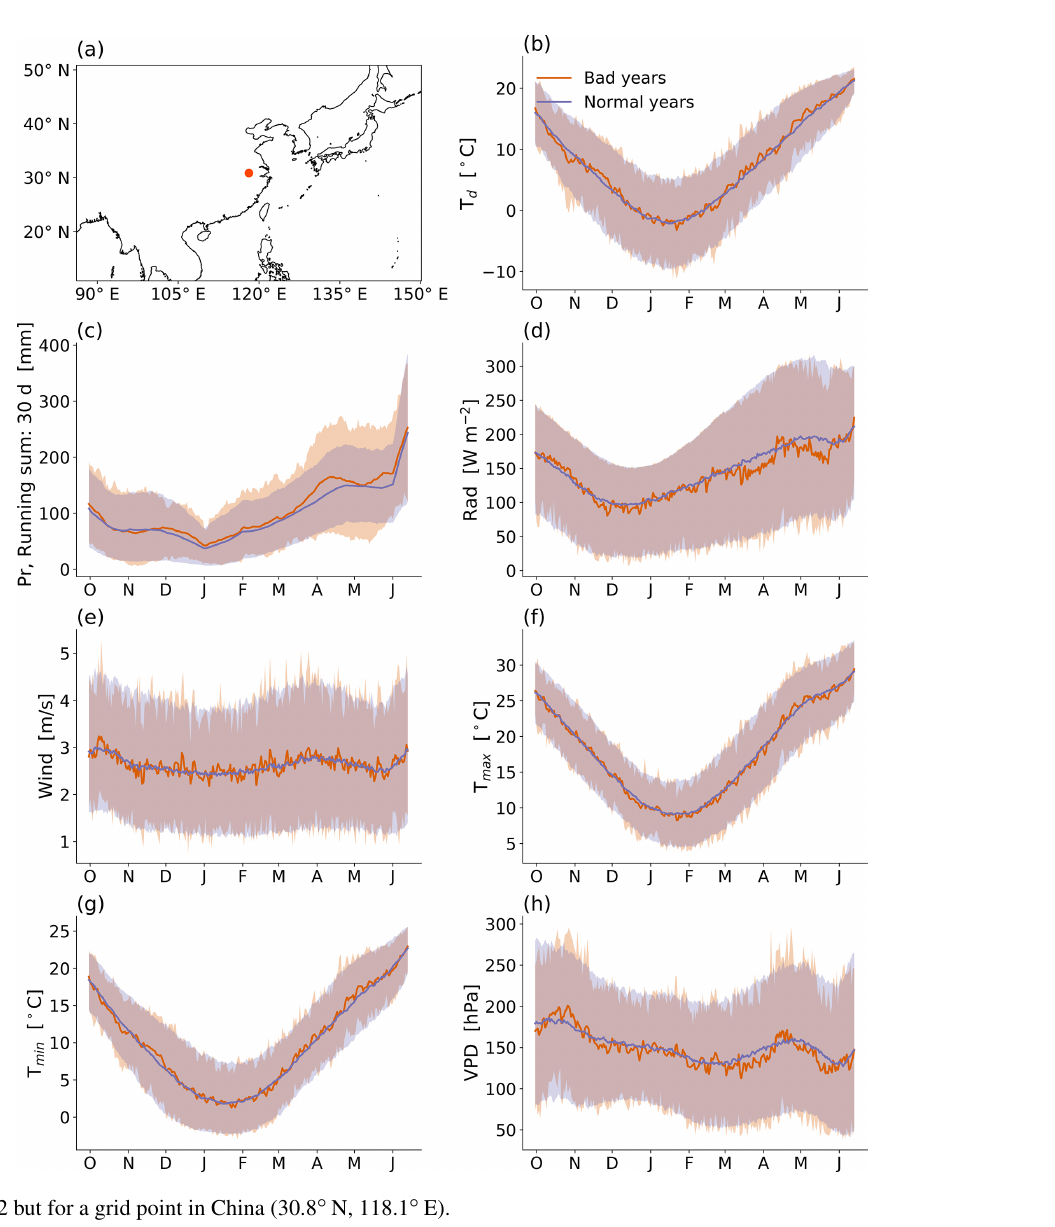
Figure B3. As Fig. 2 but for a grid point in China (30.8 ◦ N, 118.1 ◦ E).